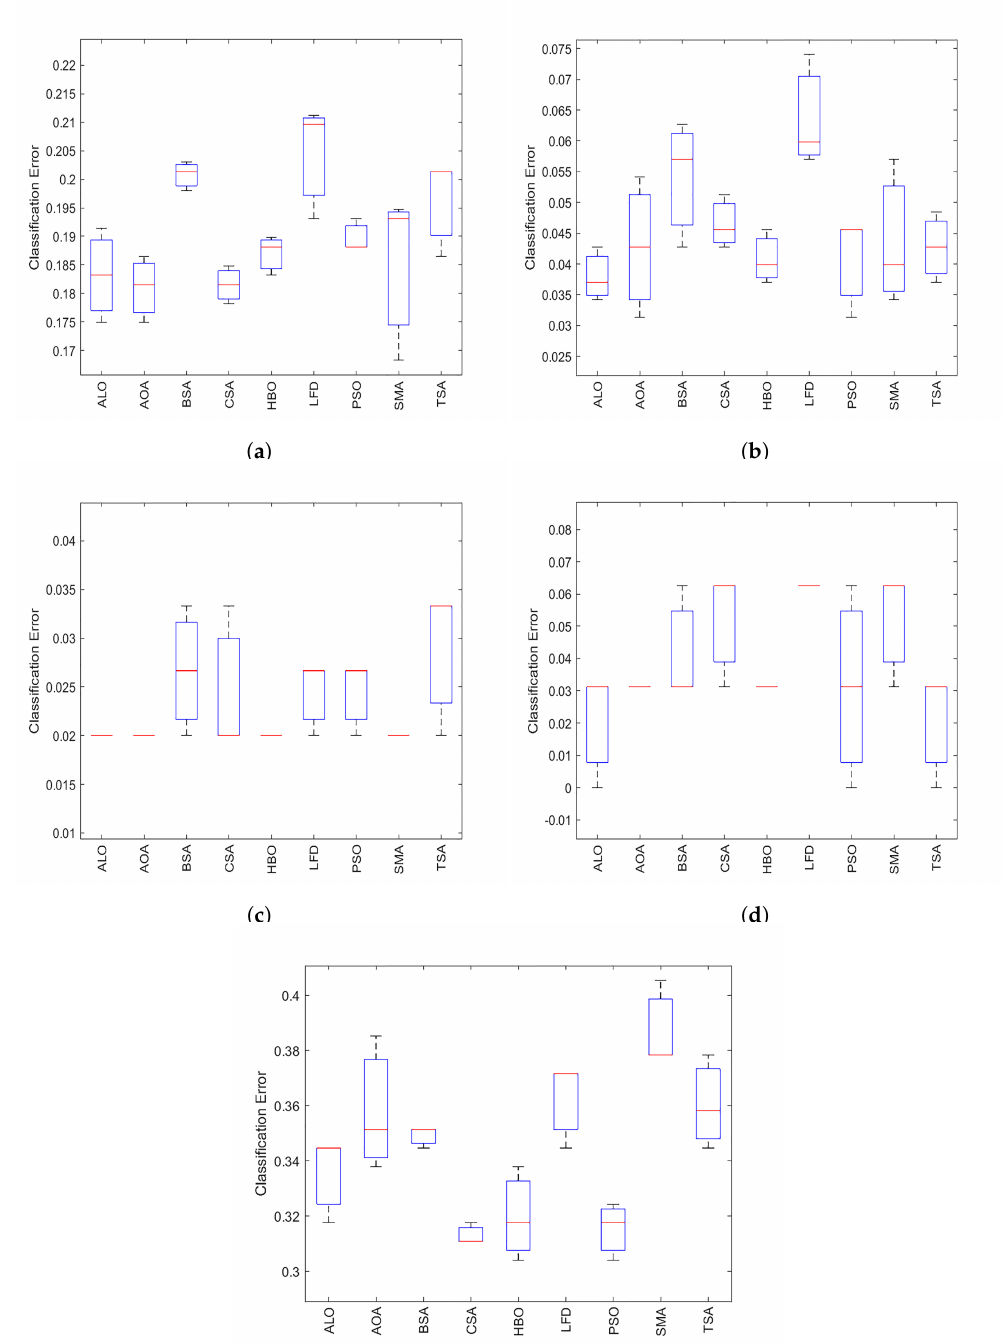
Figure 8. Boxplots of the results achieved by the B_HBO regarding classification error over Hillvalley, Ionosphere, Iris, Lung-Cancer, and Lymphography datasets regarding classification error. ( a ) Classifi- cation error of the proposed approach for Hillvalley dataset. ( b ) Classification error of the proposed approach for Ionosphere dataset. ( c ) Classification error of the proposed approach for Iris dataset. ( d ) Classification error of the proposed approach for Lung-Cancer dataset. ( e ) Classification error of the proposed approach for Lymphography